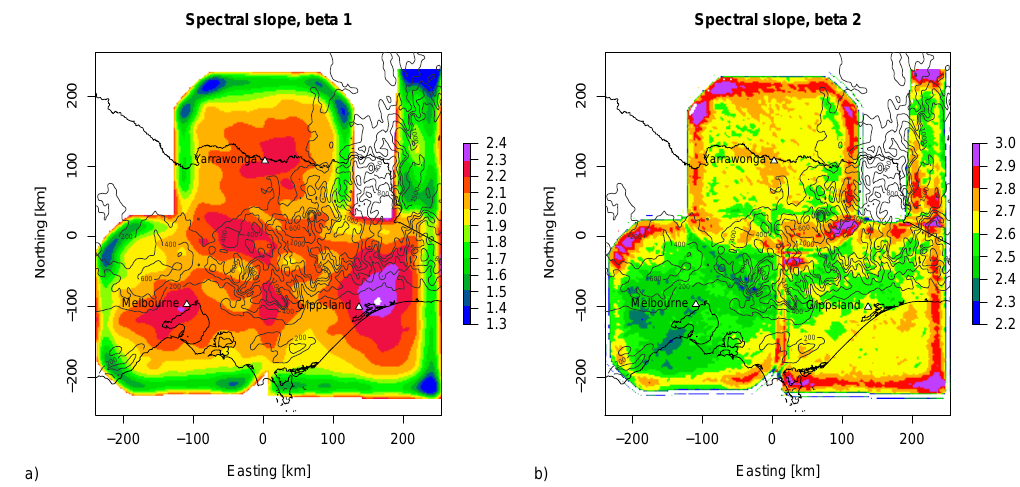
Figure 4. Spatial distribution of the spectral slopes (a) β 1 and (b) β 2 derived by assuming the scaling of the standard deviation of the cascade